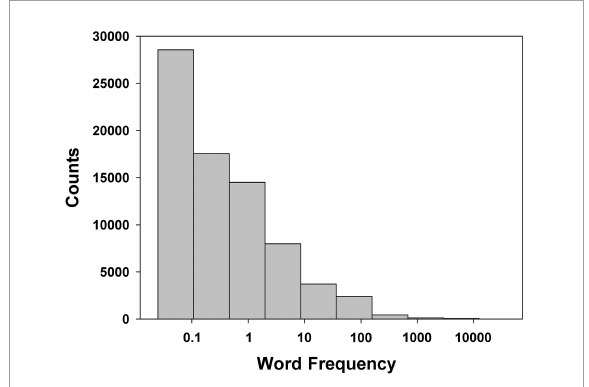
this example). Bins are created by partitioning the frequency range into ten intervals of equal log frequency width. The abscissa represents occurrences of a word per one million words (log scale). Data is based on the SUBTLEX-US database (Brysbaert and New,